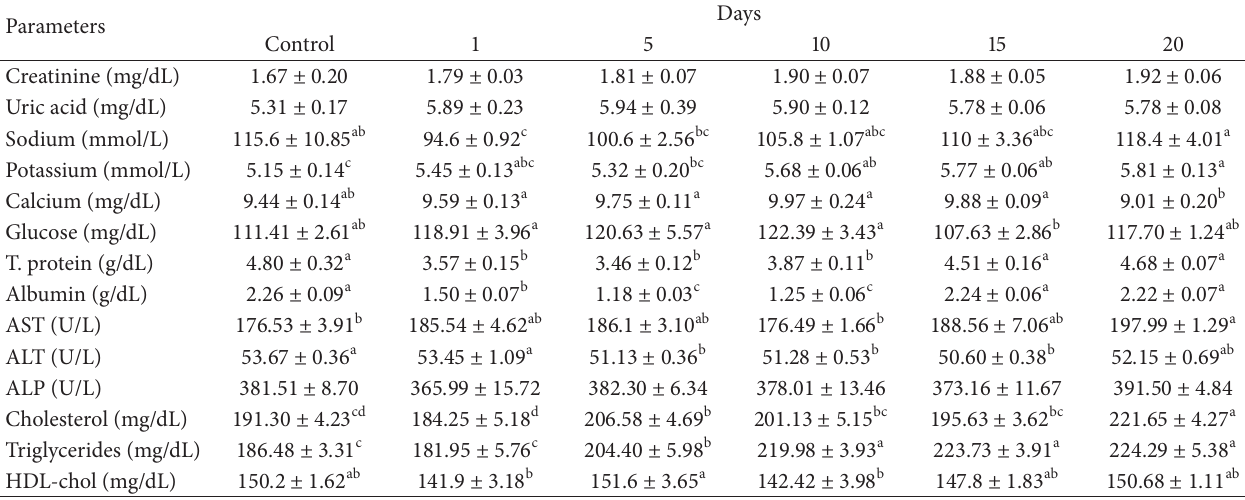
Table 3: Effect of repeated oral administration of 25 mg/kg BW of tilmicosin daily for 5 consecutive days on some biochemical parameters in broiler chicken ( 𝑛 = 5